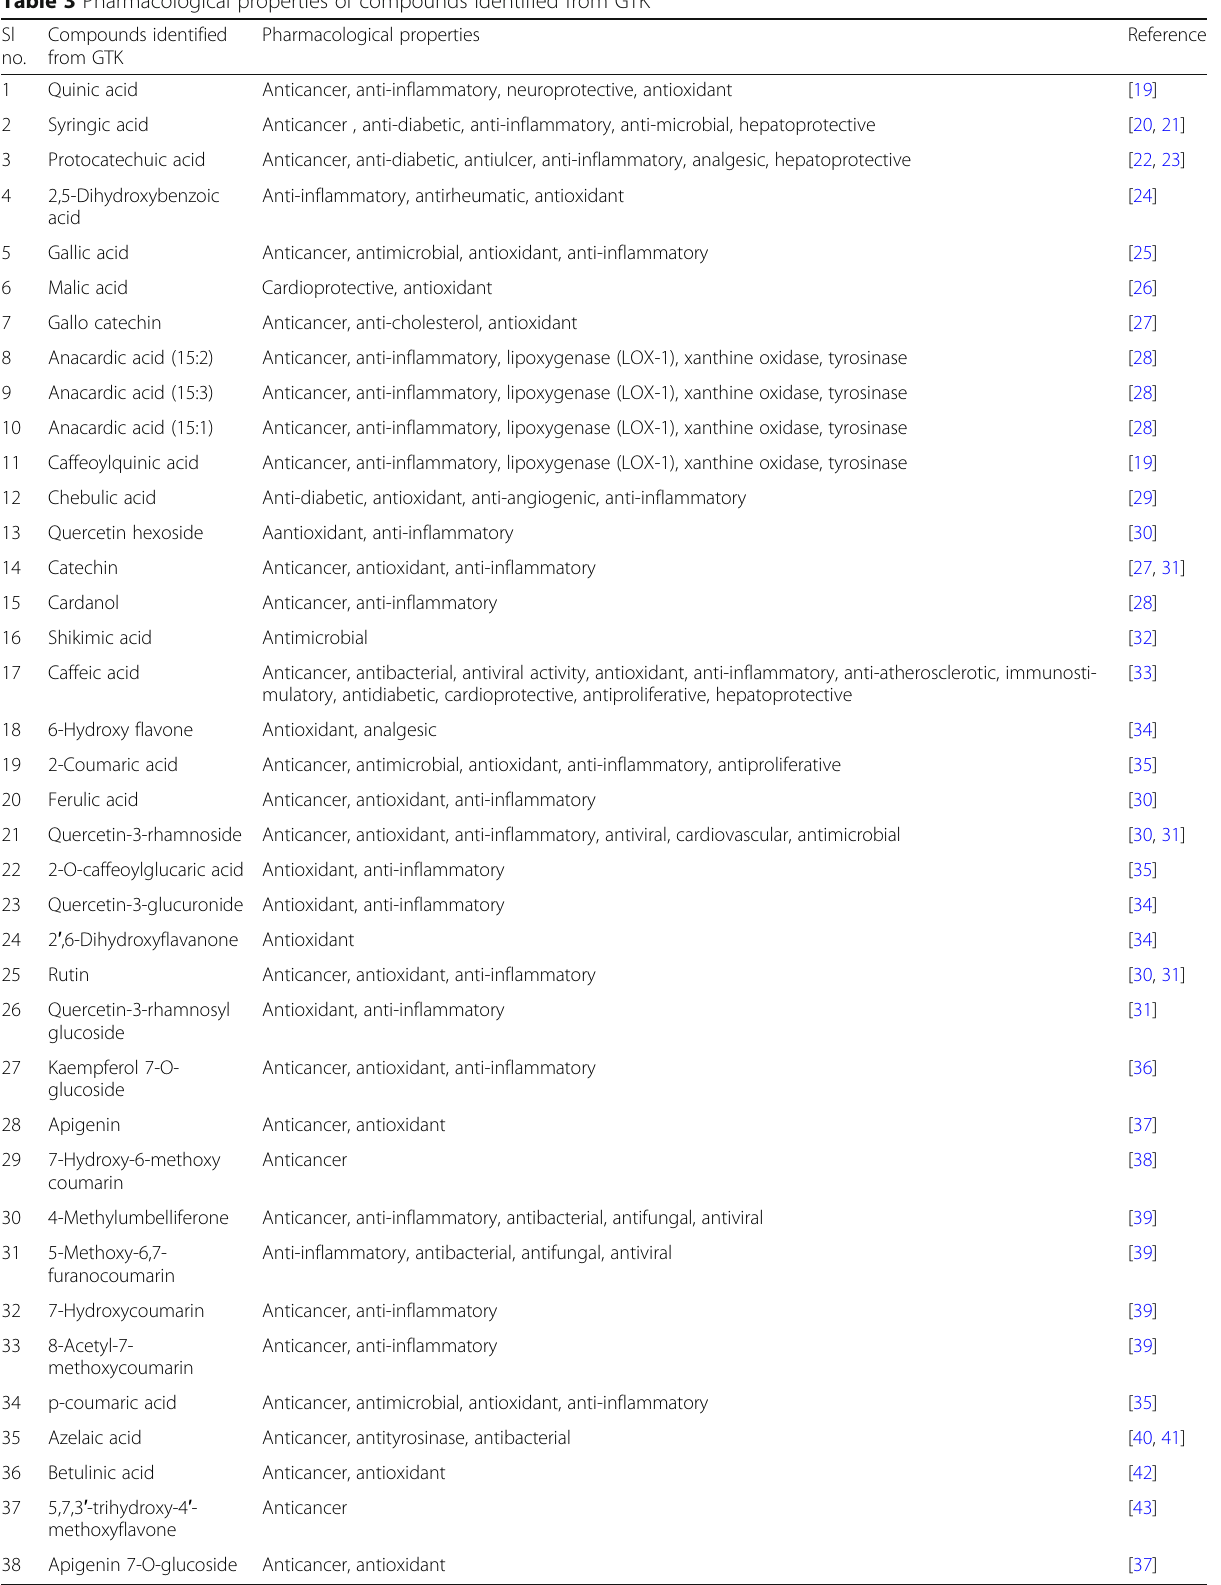
Table 3 Pharmacological properties of compounds identified from GTK Sl Compounds identified no. from